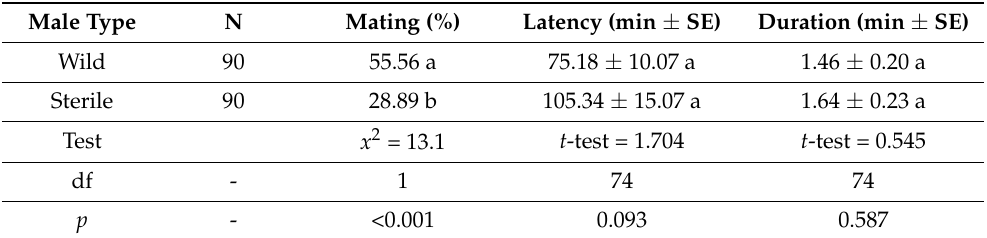
Table 6. Mating propensity of sterilized and wild Aedes albopictus males in no choice experiments involving wild virgin